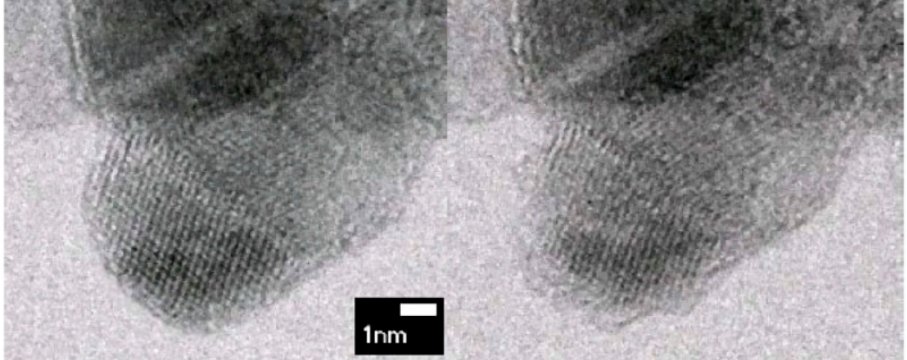
Figure 42. BF STEM images showing a twinned detonation nanodiamond particle after a few seconds of observation ( left panel ) and after ~1 min exposure to the electron beam ( right panel ). Reproduced